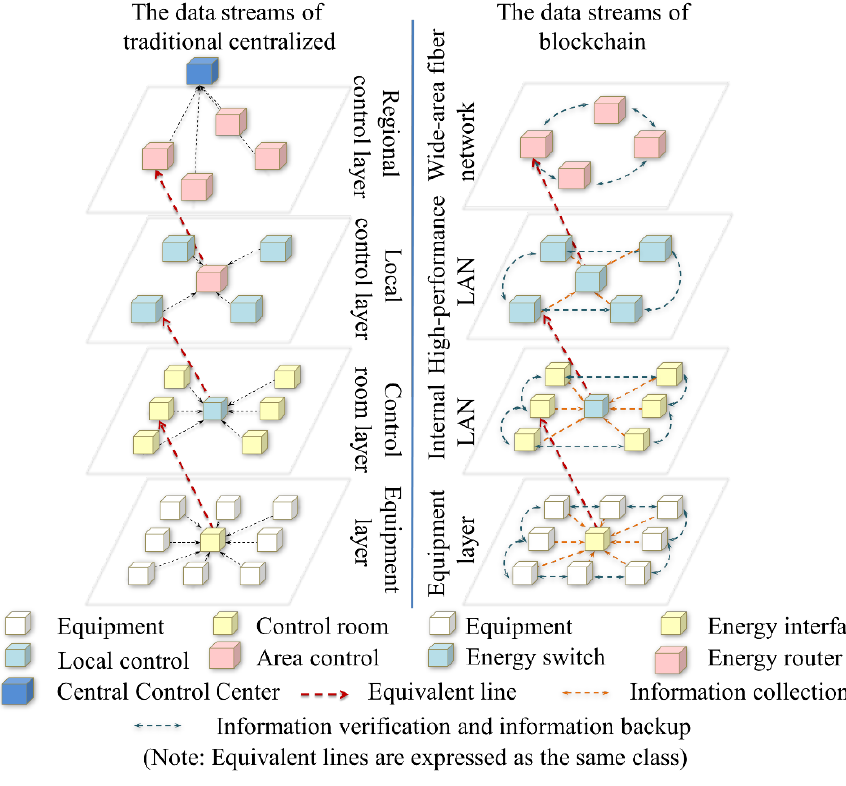
Figure 7. Comparison on information flow and structures between the traditional centralized and blockchain technologies.